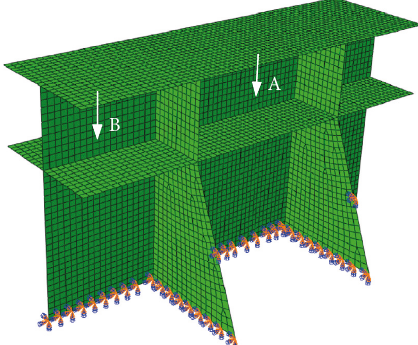
Figure 6: The finite element model, excitation points, and boundary conditions.